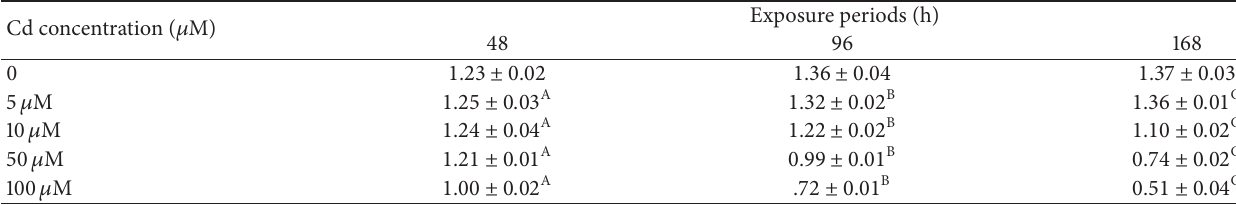
Table 2: Effect of cadmium on the chlorophyll content (mg g − 1 fw) in B. monnieri at different concentrations and exposure periods. Cd concentration ( 𝜇 M)